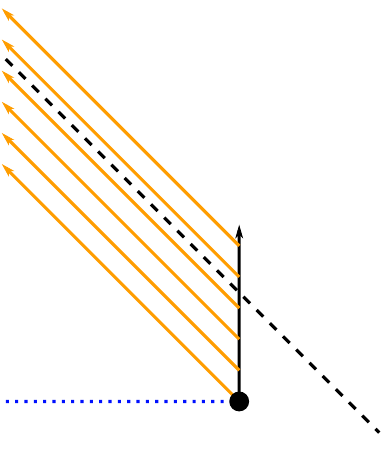
Figure 14 . The gravitational redshift of a laser signal near a horizon. The horizon is the dashed line, the worldline of the laser is black, and the dotted blue line is the dressing geodesic for the laser